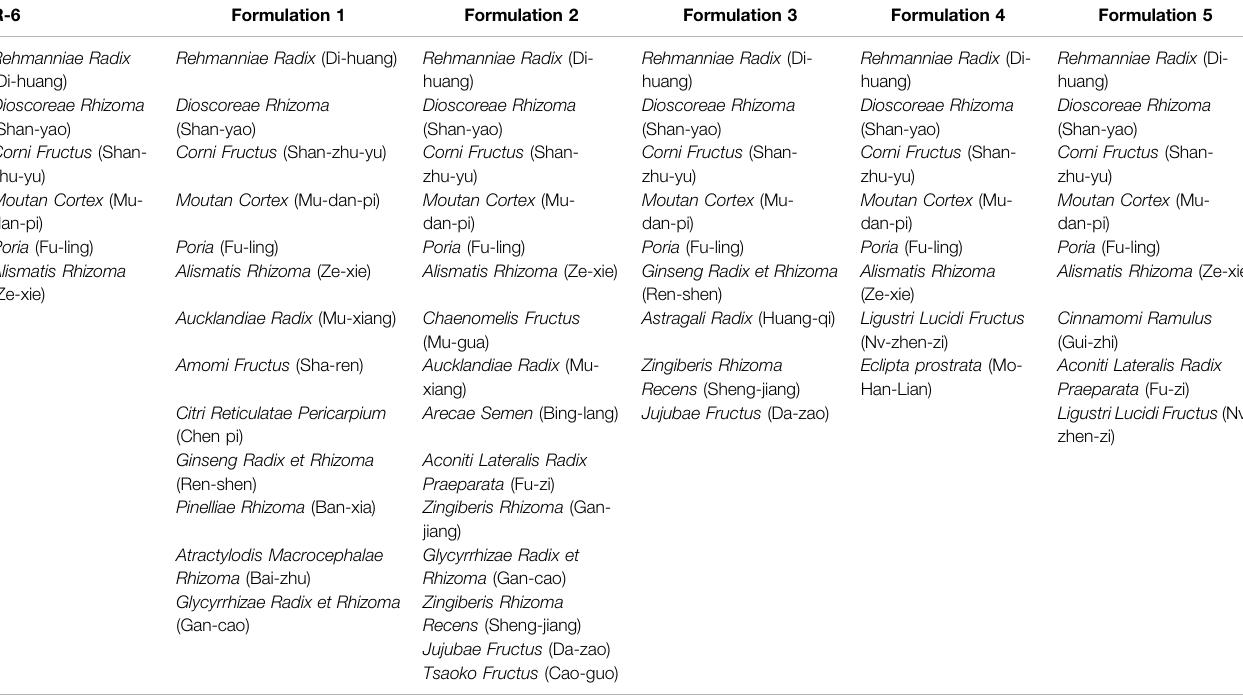
TABLE 1 | Variations of